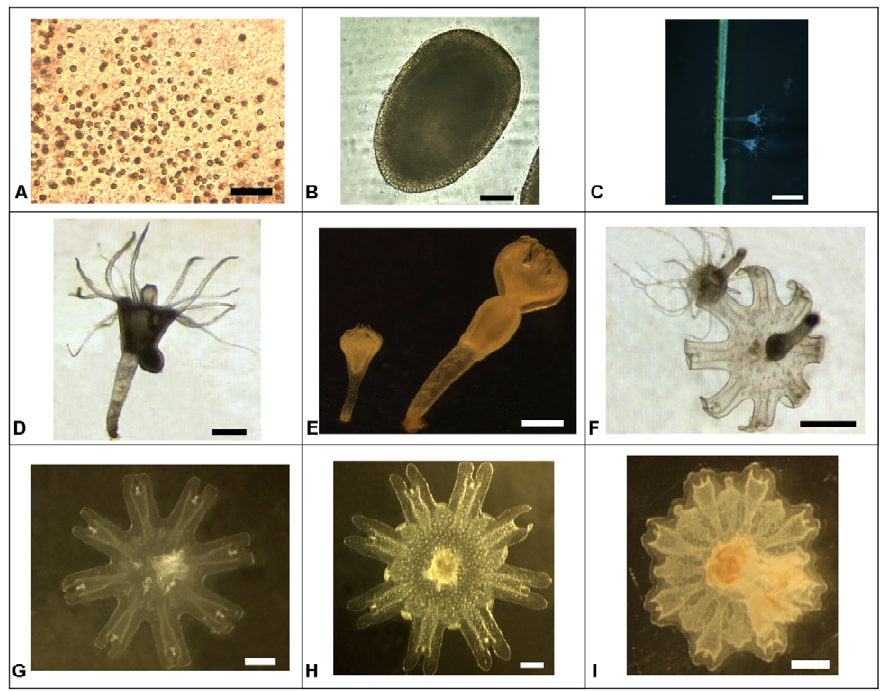
Figure 1. Cotylorhizatuberculata . Various stages of its life history. Pictures obtained during the simulation of Cotylorhiza tuberculata life cycle in the laboratory. A ) Symbiotic zooxanthellae in the tissue of the mature medusae (scale 50 m m); B ) Planula (scale 50 m m); C ) Detail of scyphistomae on the leaves of the marine angiosperm Cymodocea nodosa (scale 2 mm); D ) Budding scyphistoma (scale 500 m m); E ) Scyphistoma initiating strobilation (scale 500 m m); F ) Scyphistoma totally developed and scyphistoma about to liberate an ephyra (scale 500 m m); G ) Ephyra (500 m m); H ) Metaephyra (scale1 mm); I ) Young medusa (scale 1 mm). Authors of the pictures: C. Lama: A; J.B.Ortiz: B; L.Prieto: C; D.Astorga: D–I. Experiment B: Settlement at constant salinities. Four